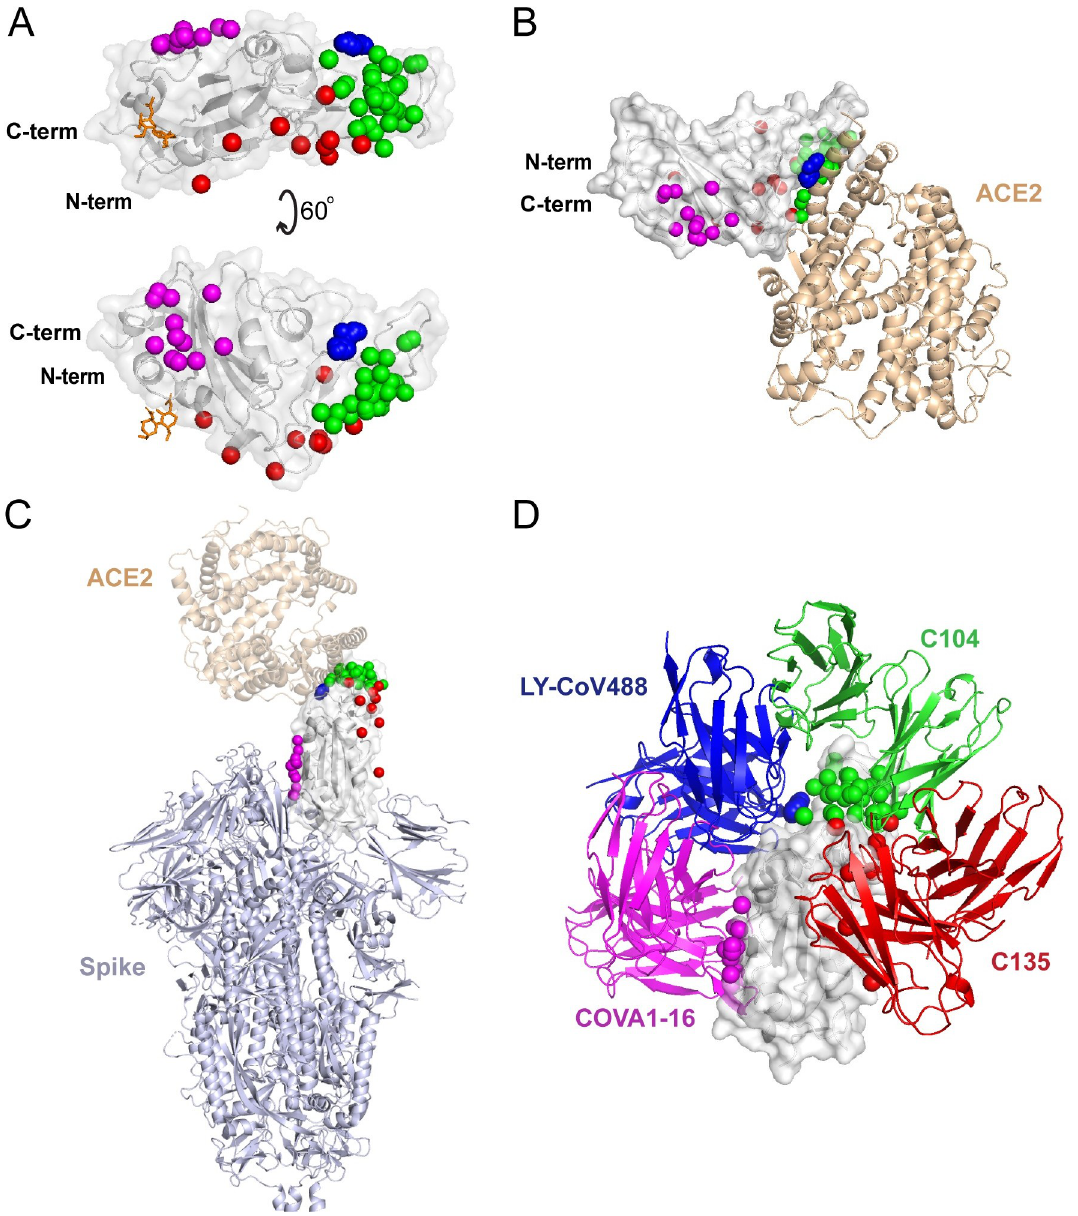
Fig 3. Distribution of antibody clusters on the receptor binding domain. (A) Each antibody is represented as a sphere at the paratope center (centroid of all non-hydrogen atoms within 5 Å of the RBD), and colored by contact-based antibody cluster (1: blue, 2: green, 3: red, 4: magenta). A representative RBD structure (from PDB code 7KN5) is shown in gray, and the N-glycan at residue N343 from that structure is shown as orange sticks. (B) RBD structure with antibody clusters and superposed ACE2 receptor (tan cartoon; PDB code 6LZG [52]). (C) RBD antibody clusters shown in the context of the spike glycoprotein (light blue cartoon; PDB code 6VYB [68]) with the RBD in an open state. (D) Representative antibodies from each cluster, labeled by antibody name and colored by cluster, superposed onto the